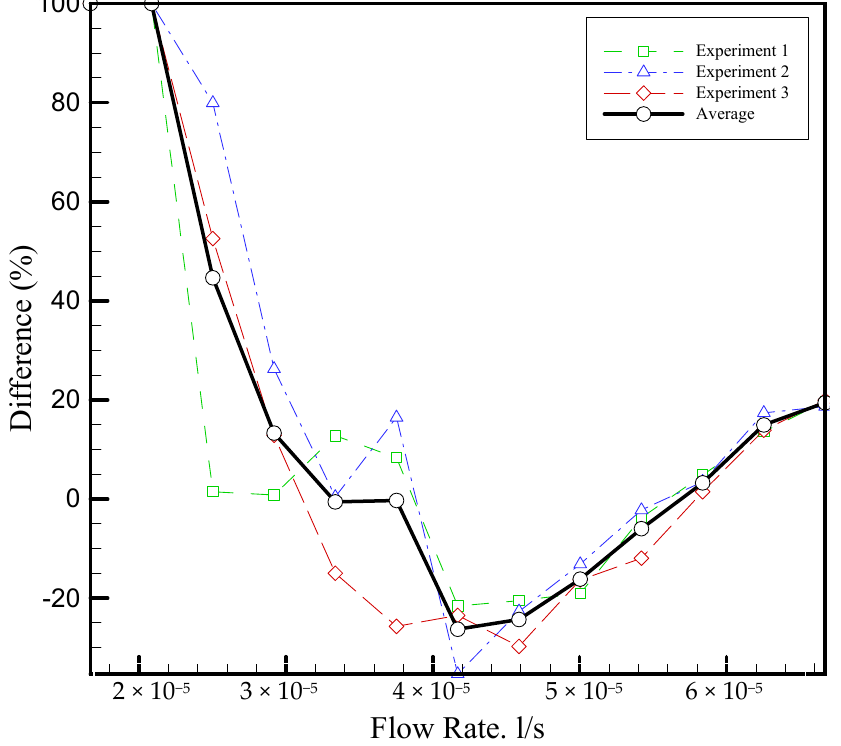
Figure 10. Graph of percentage difference between experimental and theoretical EMF output.